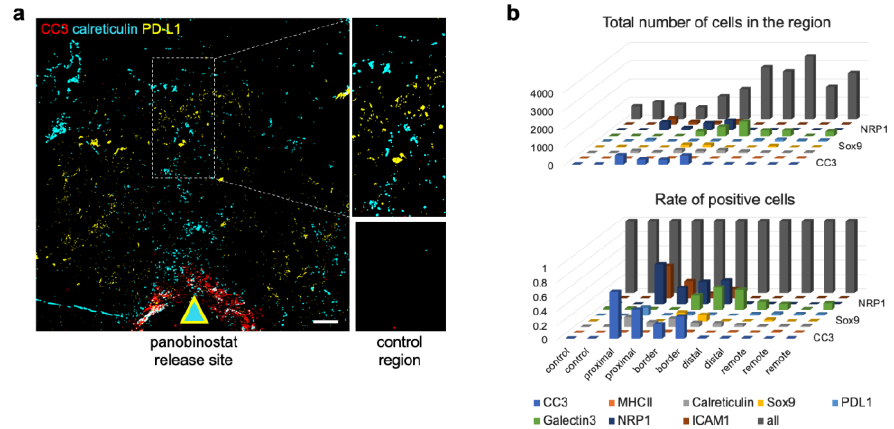
Figure 3. Spatial distribution of the ICB biomarkers at local panobinostat drug-delivery site. ( a ) A sample composite image of cell death (CC3), DAMP (calreticulin), and an established marker of ICB efficacy (PD-L1) at the panobinostat well. Control region: bottom right. Scale bar: 200 µ m. The image was adapted from [1]. ( b ) Quantification of candidate biomarkers after zonal stratification, presented in the form of a 3D bar graph. Two to three replicates are presented per zone.